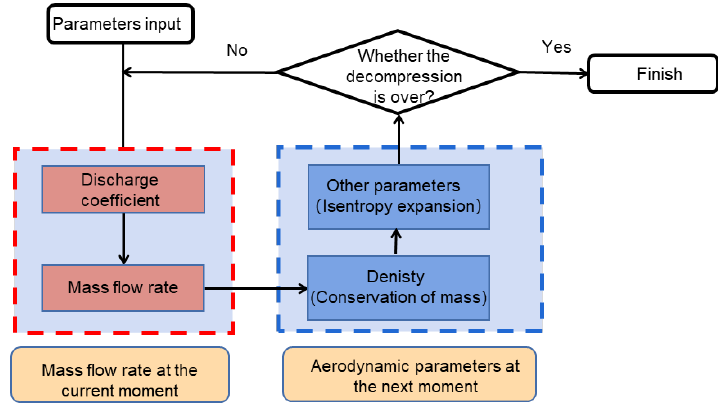
Figure 2. Calculation process of the 0-D model.